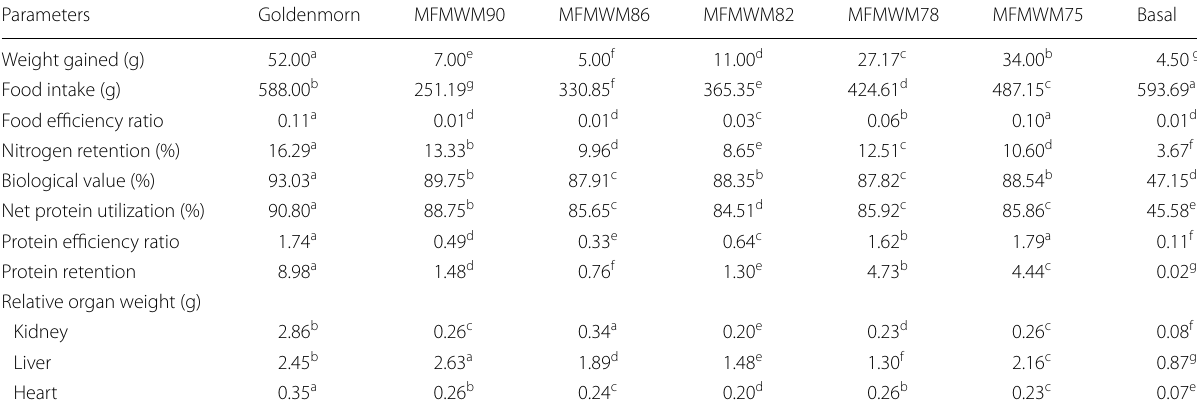
Means with different alphabetical superscripts in the same row are significantly different at P < 0.05 Key: Goldenmorn (commercial control breakfast meal); Basal (animal chow); MFMWM90: Malted finger millet:Watermelon seeds (90.00:10.00%); MFMWM86: Malted finger millet:Watermelon seeds (86.25:13.75%); MFMWM82: Malted finger millet:Watermelon seeds (82.50:17.50%); MFMWM78: Malted finger millet:Watermelon seeds (78.75:21.25%) and MFMWM75: Malted finger millet:Watermelon seeds (75.00:25.00%)